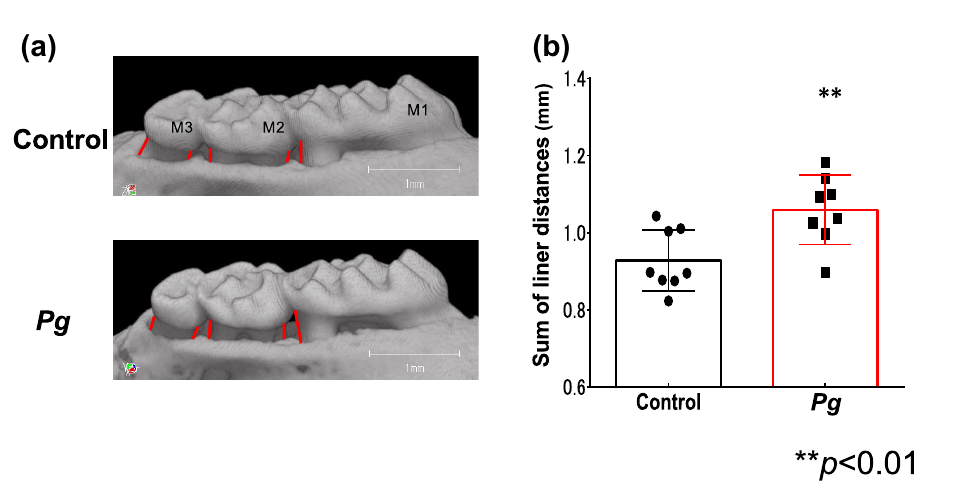
Figure 1. Effects of oral Porphyromonas gingivalis ( Pg ) - administration on alveolar bone loss in db / db mice ( a ) Buccal-side maxillary alveolar bone loss (ABL, colored lines), measured from the cemento-enamel junction (CEJ) to alveolar bone crest (ABC) at five points: (1) distobuccal regions for first maxillary molar (M1); (2) mesiobuccal (3) distobuccal regions for second maxillary molar (M2); (4) mesiobuccal and (5) distobuccal regions for third maxillary molar (M3), in db / db mice treated with Pg or CMC control for 30 d. ( b ) Comparison of the sum of the five CEJ-ABC linear distances. ** P < 0.01; n = 8. Data are shown as mean ± SEM.